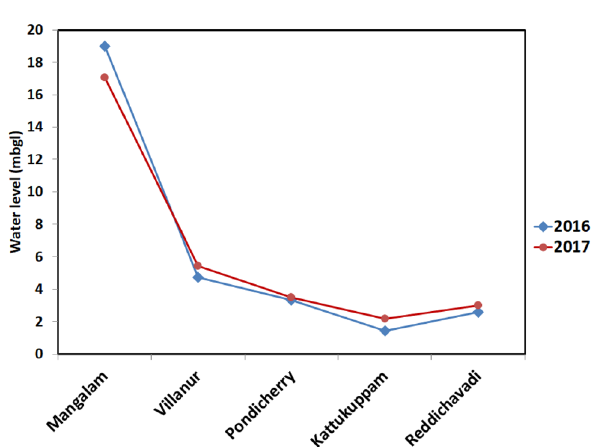
Fig. 2 3D variation of Resistivity (Ωm) and lithology (m) of the Study region